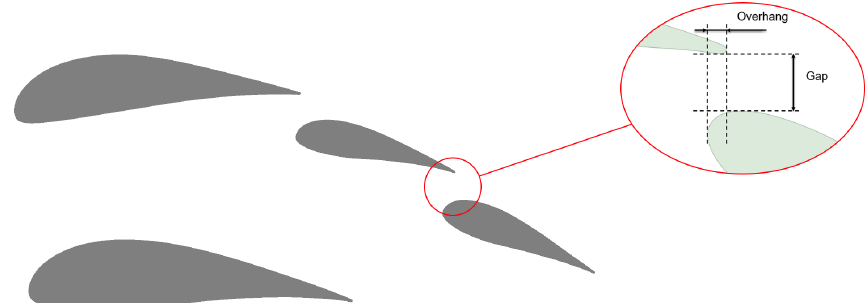
Figure 12. Definition of overhang and gap.